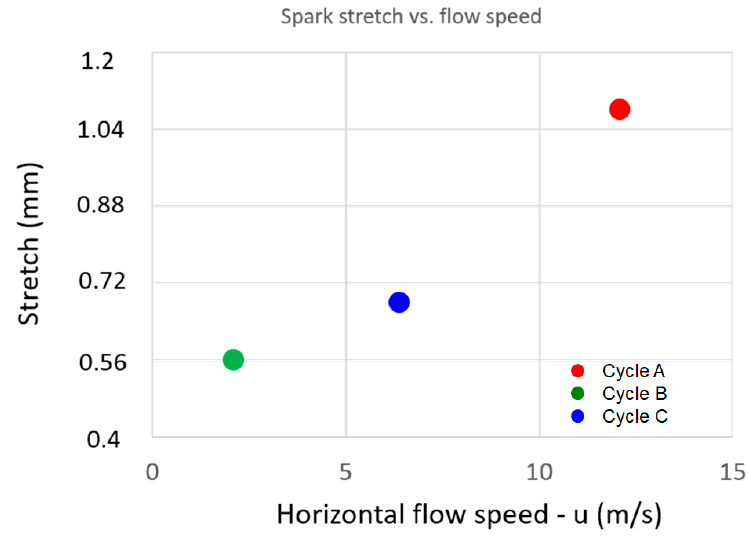
Figure 8. Flow speed and spark stretch relationship of selected cycles at 1700 rpm condition.